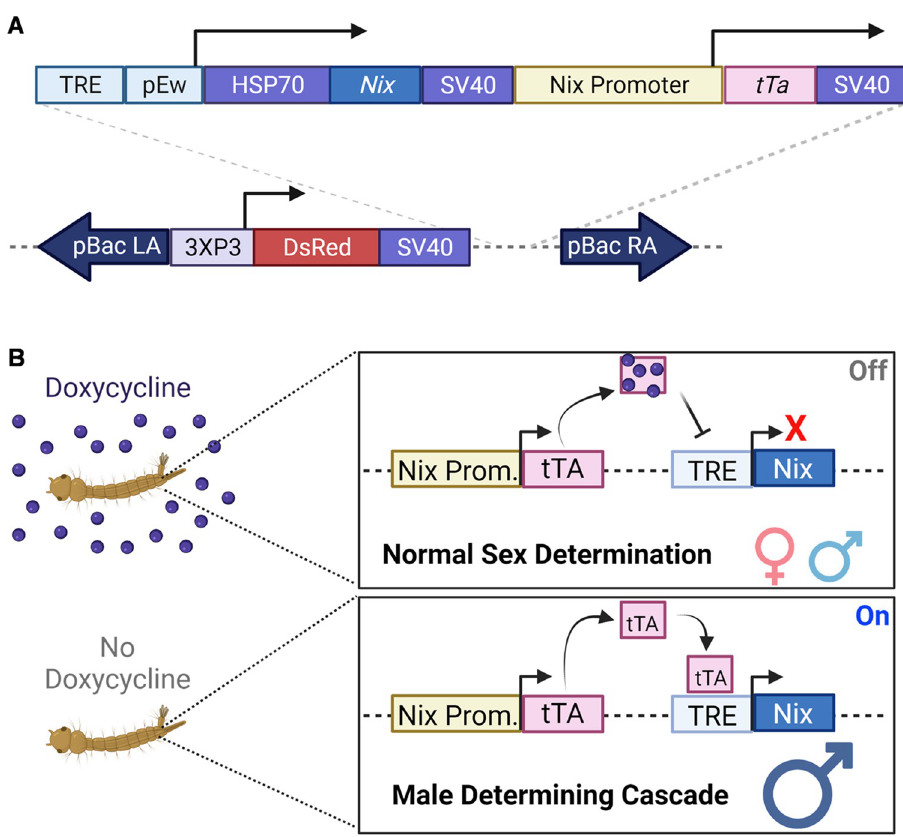
Fig 1. ( A ) A schematic of the pTRE-Nix/NixPro-tTA transformation construct and its landing site on the genome of transgenic lines. PiggyBac right arm (pBac R. A.) and left arms (pBac L. A.) are indicated, along with the 3XP3-DsRED marker cassette. The dotted lines represent sequence from the plasmid backbone. The pTRE-Nix/NixPro-tTA construct introduced another two genes: 1) The P element week promoter (pEw) driving the expression of the Nix protein. Upstream the promoter is the tetracycline responsive element (TRE) and downstream is the leader sequence of the heat shock protein 70 (HSP70). 2) The Nix promoter sequence driving the expression of the tetracycline Trans activator (tTA). All three genes on this construct have the 3’UTR from the simian virus 40 (SV40). ( B ) Schematic representation of the Tet-off system. Nix promoter (Nix Prom.). Illustrations were created using Biorender.com through a license to Texas A&M